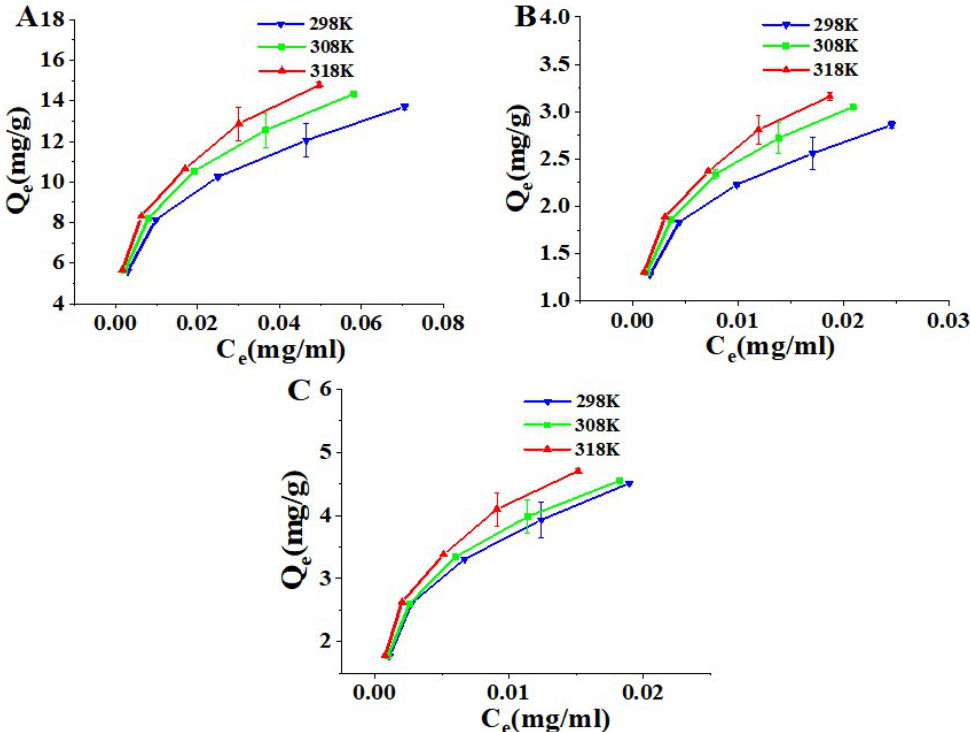
Figure 4. Adsorption isotherms of osthole ( A ), columbianetin acetate ( B ), columbianadin ( C ) on HP-20 resin at different temperature. The equilibrium concentration (C e ). The adsorption capacities at equilibrium (Q e ).